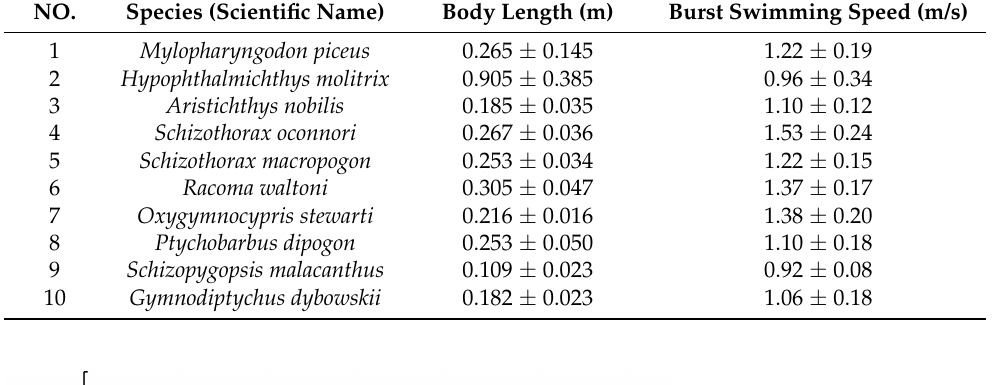
Table 4. Swimming ability of different fish species.